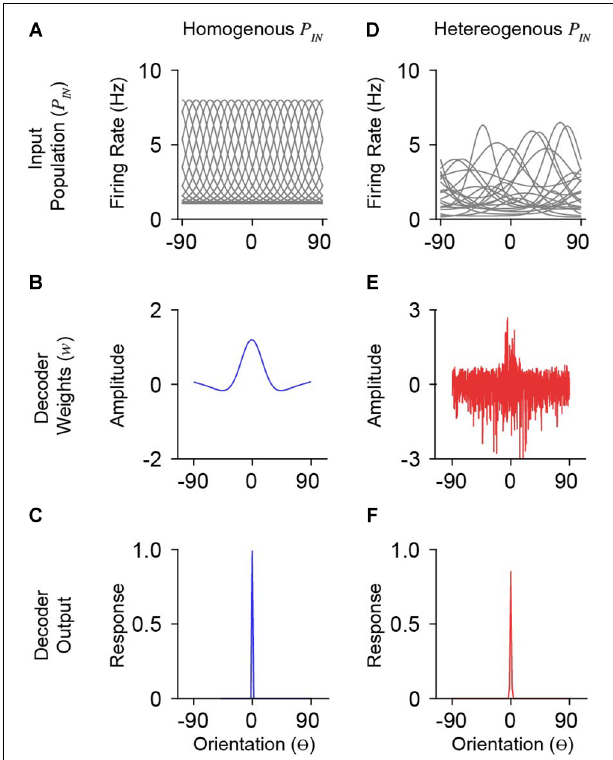
FIGURE 2 | Model simulations with homogenous and heterogeneous input populations. (A) Orientation tuning of a homogenous input population. Shown is a subset of the total population ( n = 20/1,000). The ordinate is orientation preference, restricted between − 90 o and 90 o . (B) Derived weights for a single decoder neuron (preferring 0 o ) reading out the homogenous (blue) input population in (A) . Weights for homogenous populations smoothly vary over orientation space. (C) Response output of the decoder neuron whose weights are shown in (B) . (D–F) Same as in (A–C) for a heterogeneous input population with moderate correlation ( c o = 0.25). Note that decoder weights for heterogeneous input populations are not